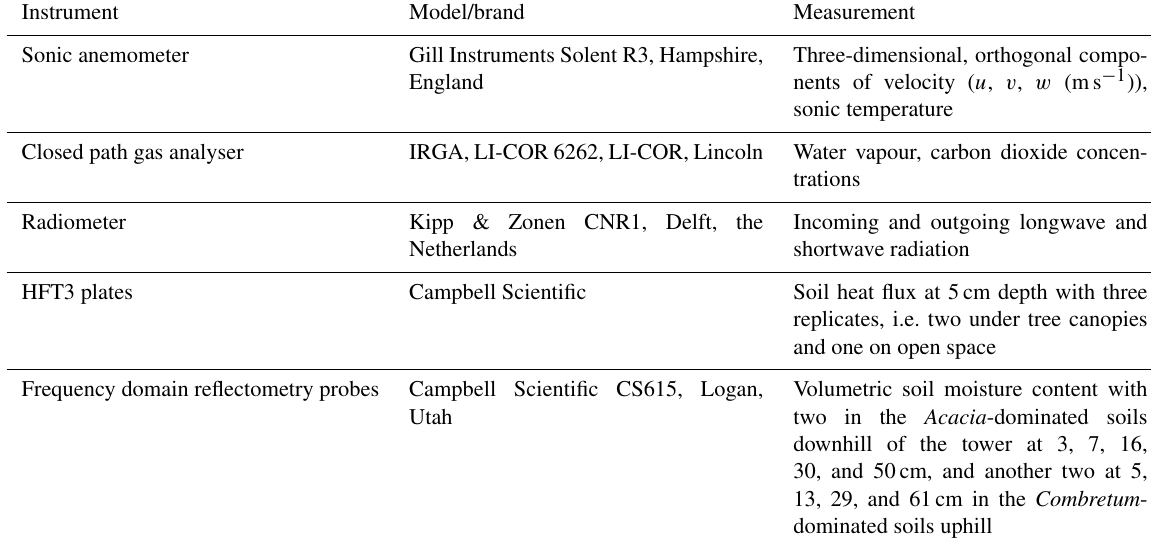
Table 1. Measurements taken and instruments used at Skukuza flux